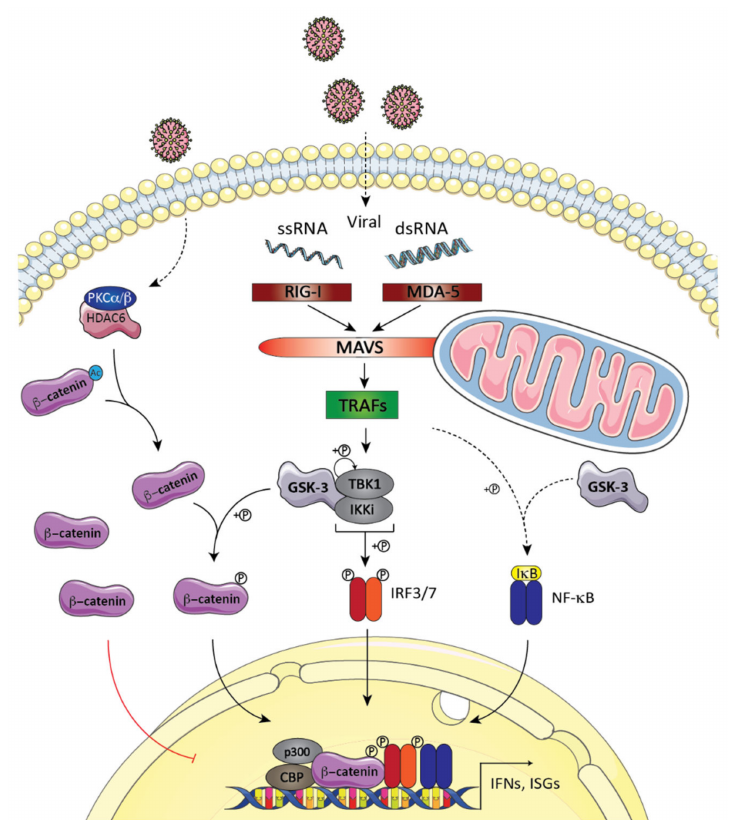
Figure 3. Fine-tuning the RLR-induced type I IFN response by GSK-3 and β -catenin. The recognition of double-stranded RNA (dsRNA) molecules and 5 (cid:48) triphosphate single-stranded RNA (ssRNA) by MDA5 and RIG-I, respectively, induces the polymerization of the mitochondrial adaptor protein MAVS (mitochondrial antiviral signaling). The recruitment of tumor necrosis factor (TNF) receptor-associated factors (TRAFs) to polymerized MAVS results in the activation of the constitutively expressed protein kinase TANK-binding kinase 1 (TBK1) and its inducible homologue IKKi (or IKK ε ). GSK-3 acts as a sca ff olding entity that allows for the oligomerization and activation, of TBK1, leading to the phosphorylation and activation of transcription factors like IRF3. The activation of IRF3 following viral infection involves multiple phosphorylation events at its C-terminal, which are followed by its dimerization, nuclear translocation, and interaction with co-activators CBP and p300. β -catenin deacetylated by HDAC6 and phosphorylated by GSK-3 acts as an IRF3 co-activator by interaction with holocomplex formed by IRF3 and CBP / p300. GSK-3 β expression is also necessary for proper I κ B phosphorylation and subsequent NF- κ B activation. On the other hand, the accumulation of unphosphorylated “active” β -catenin appears to limit the antiviral response. Arrows represent activation, whereas blocking arrows signify inhibition. The model was created using Servier Medical Art templates (www.servier.com) licensed under a CC BY 3.0 license (https: // creativecommons.org / licenses / by / 3.0 /